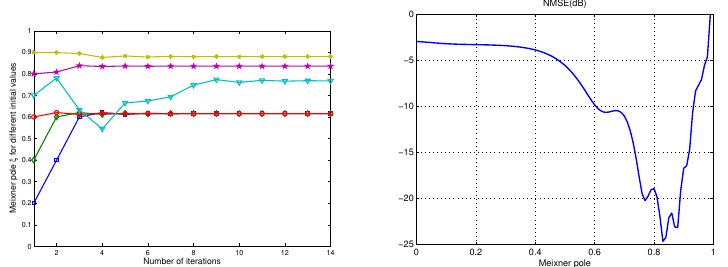
Figure 3. Identification of Meixner pole